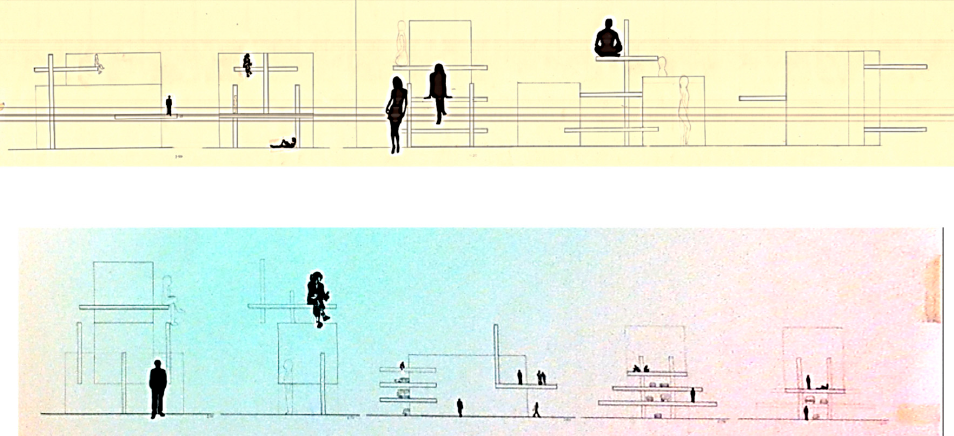
Figure 6. Representations of the three ‐ dimensional exploration.